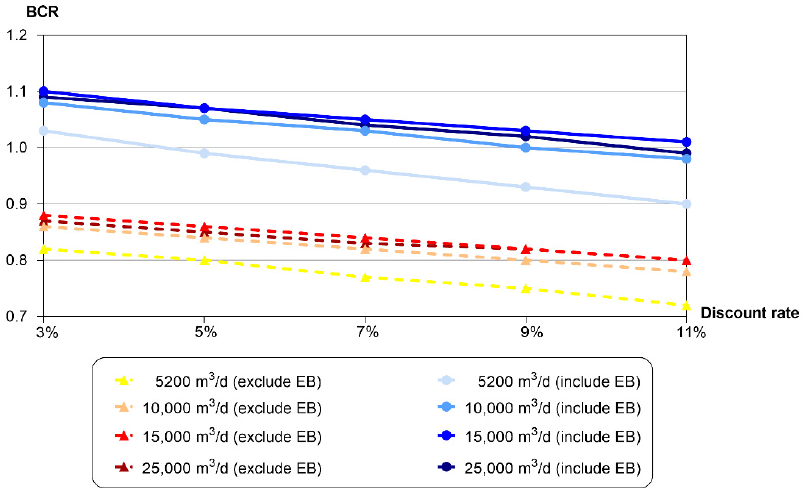
Figure 4. Benefit–cost ratios (BCRs) for water reclamation projects for industrial water supply when including and excluding environmental benefits (EB) .